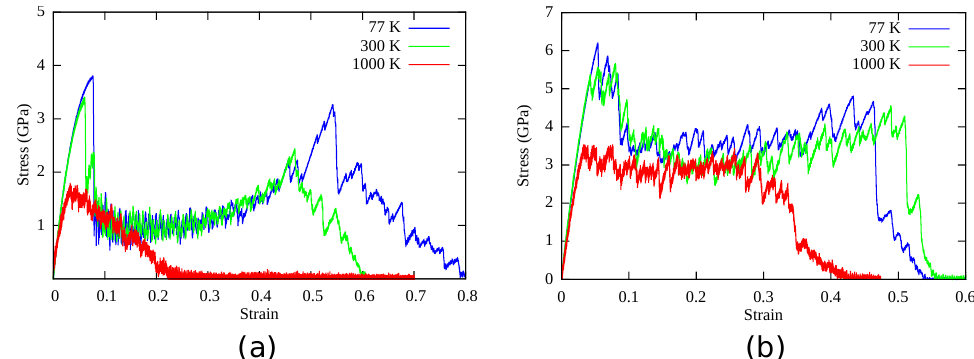
Figure 2. Stress–strain curves obtained at different temperatures during uni-axial tensile deformation of ( a ) Ag nanowires and ( b ) HEA